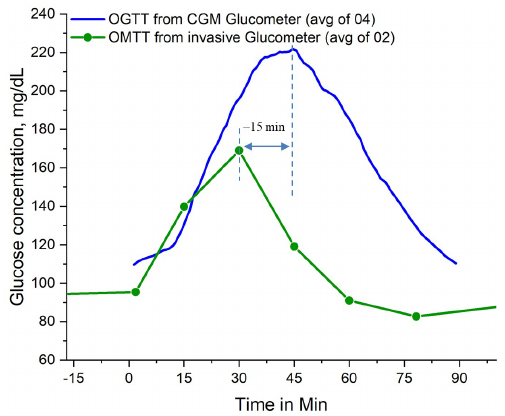
Figure 6. Comparison of glucose measurement from the commer- cial semi-invasive Free Style Libre continuous glucose monitor- ing (CGM) sensor and the commercial invasive glucometer reading. The CGM sensor was attached to the upper arm and collected glu- cose information from interstitial fluids (ISFs) every few minutes. Glucose information from a glucometer was collected every 15min by drawing blood by pricking fingertips.